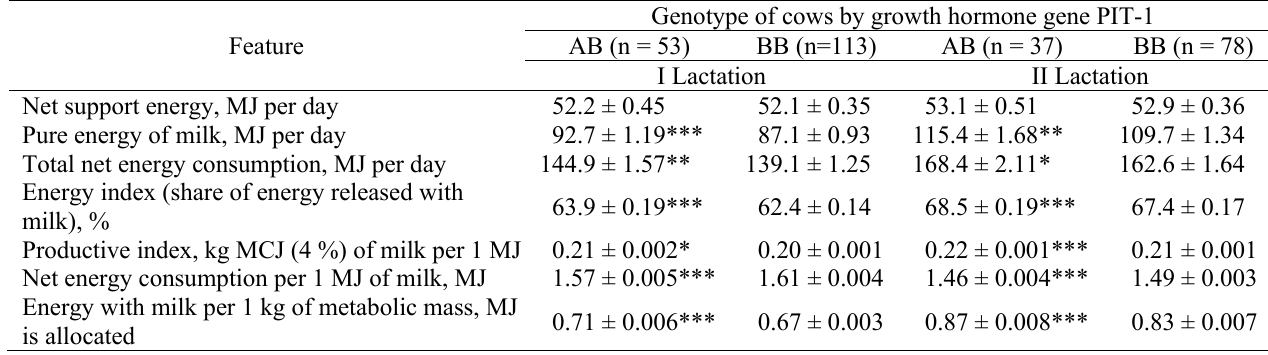
Energy evaluation of Holstein cows of different genotypes by gene